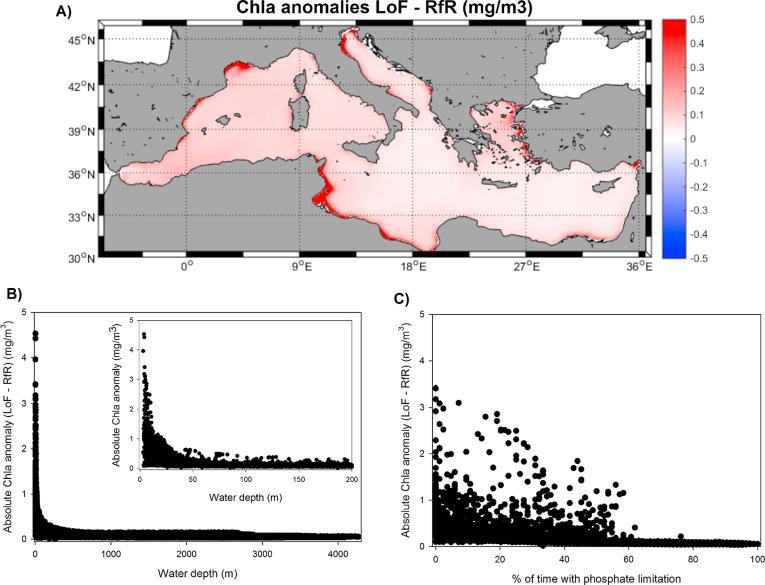
(A) Mean difference in surface chlorophyll between RfR and LoF simulations (mg/m3). (B) Scatter plot the absolute difference in surface chlorophyll between RfR and LoF versus water depth. (C) Scatter plot the absolute difference in surface chlorophyll between RfR and LoF versus the percentage of phosphate limitation.